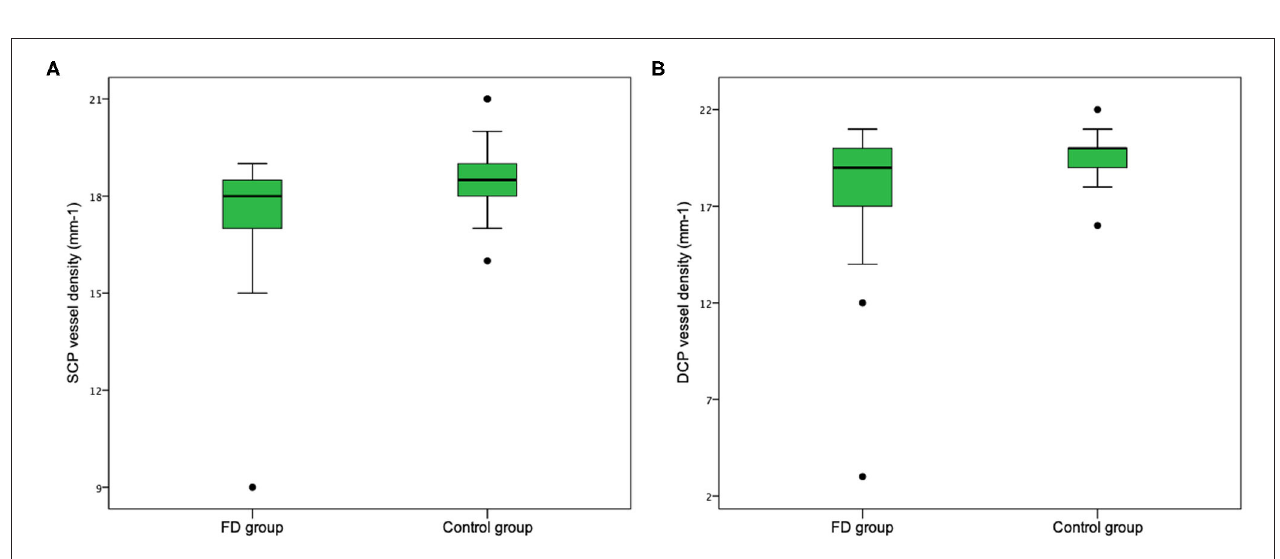
FIGURE 5 | Retinal vessel density in patients with Fabry disease and normal control group. Vessel density in both the whole superficial capillary plexus (SCP) (A) and the whole deep capillary plexus (DCP) (B) is lower in the group of patients affected by Fabry